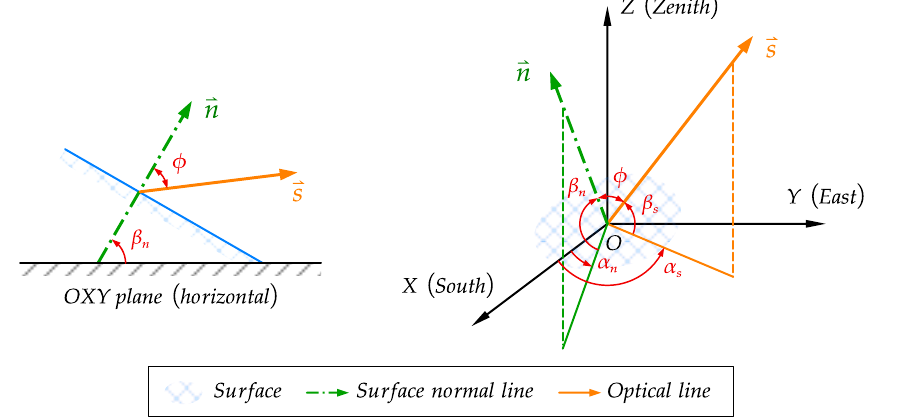
Figure 2. Diagram of coordinate system and vectors.